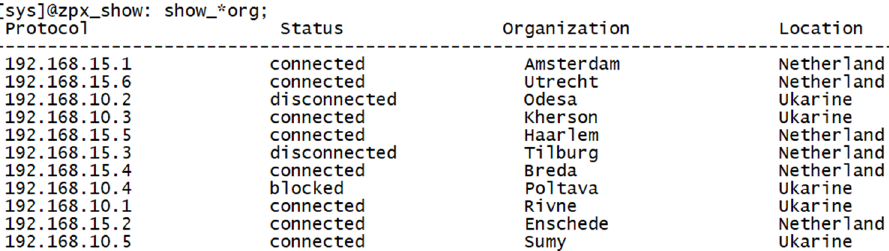
Figure 9. Exit function.